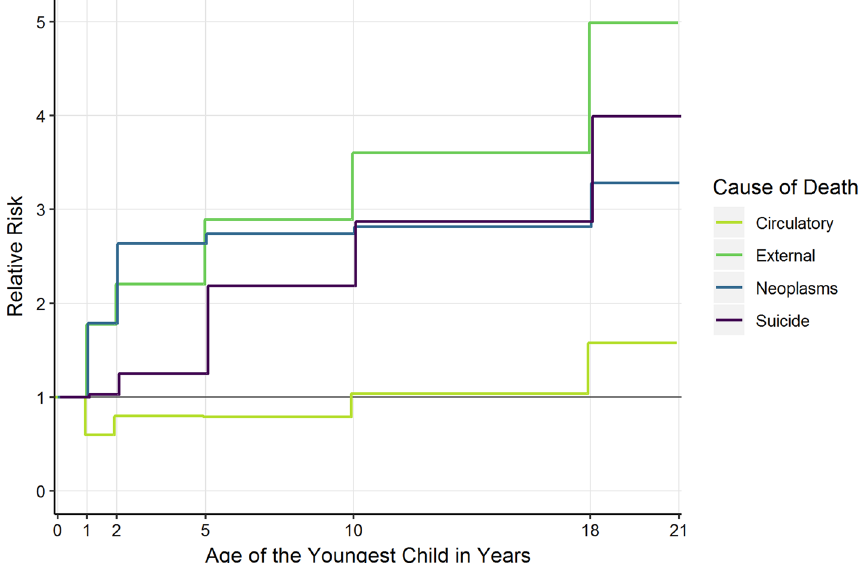
Fig. 3 Models 6a–6d (women): relative risk of dying by the age of the youngest child for selected causes